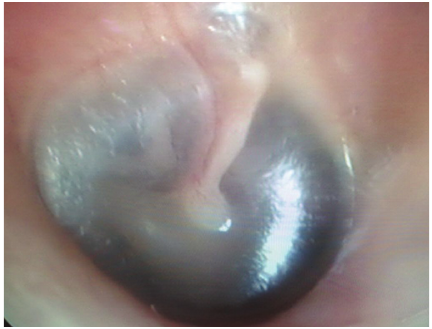
Figure 1: Otoscopic examination of the patient.